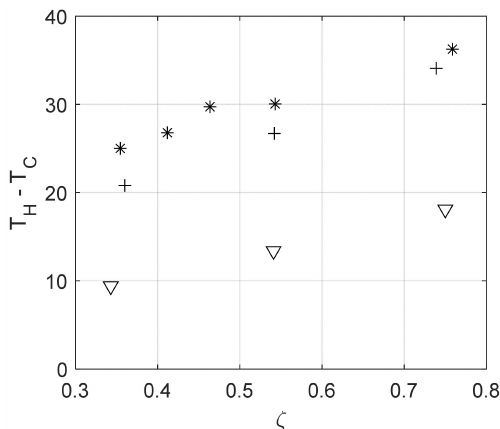
Figure 5. Comparison of experimental and numerical temperature differences between the hot and cold outlets. Stars, experimental data; crosses, standard k − ε model; triangles, realizable k − ε